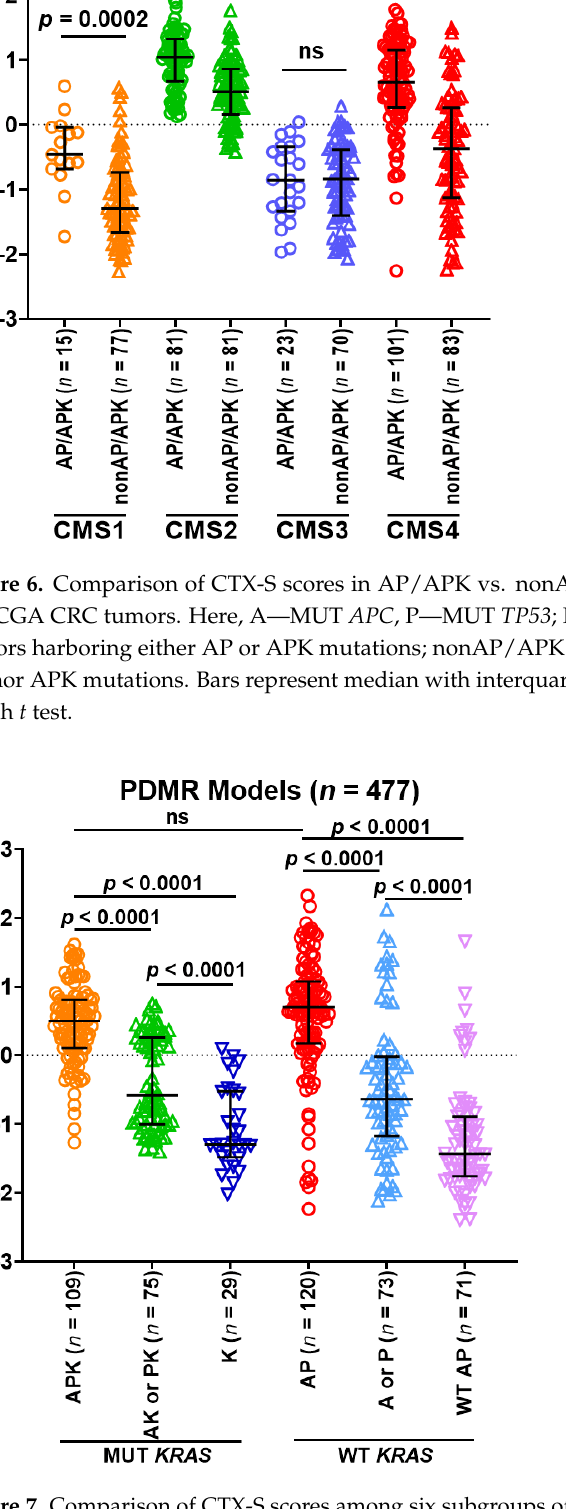
Figure 7. Comparison of CTX ‐ S scores among six subgroups of MUT APC (A)/MUT TP53 (P)/MUT KRAS (K) in PDMR CRC models. Bars represent median with interquartile range. p values are for two ‐ tailed Welch t test.